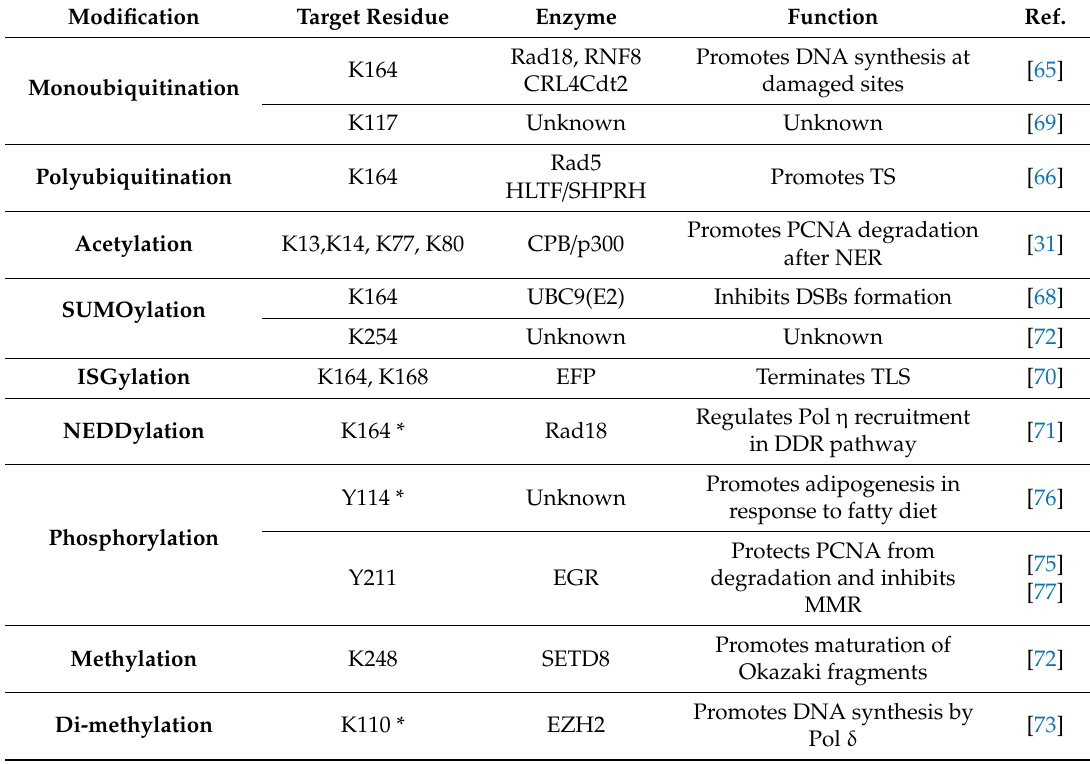
Table 1. Post-translational modifications of